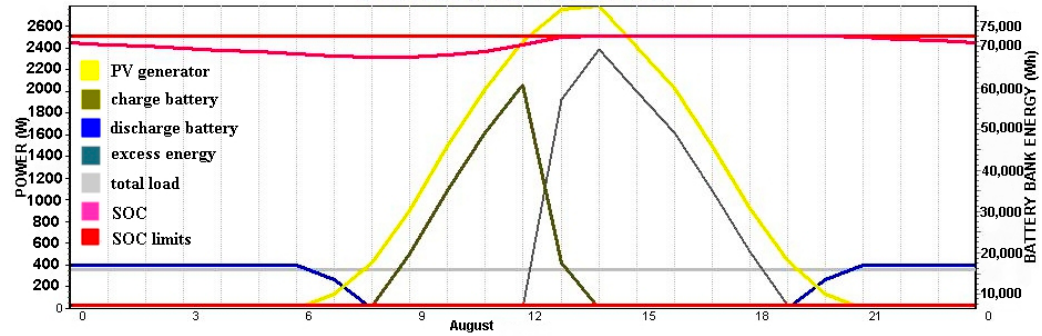
Figure 7. Hourly results for the most favorable day of system operating.